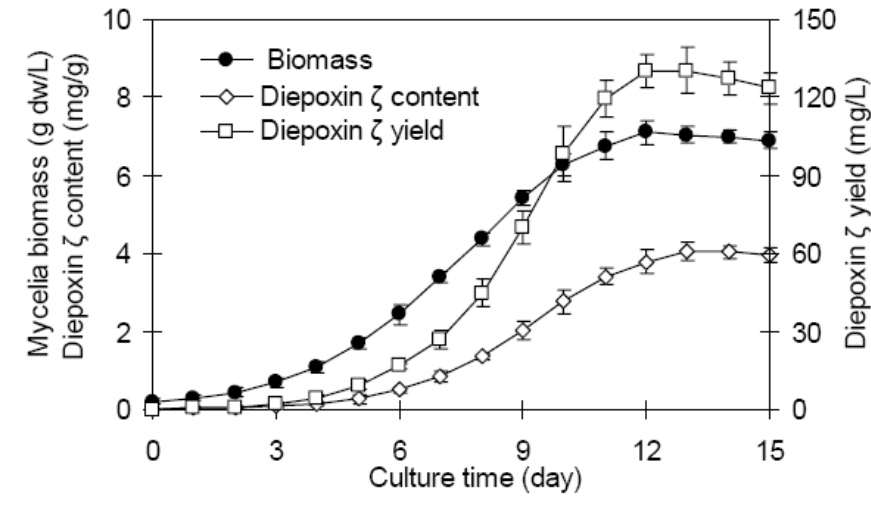
Figure 1. Time courses of mycelia growth and diepoxin ζ production in liquid culture of endophytic fungus Dzf12. The error bars represented standard deviations, n =